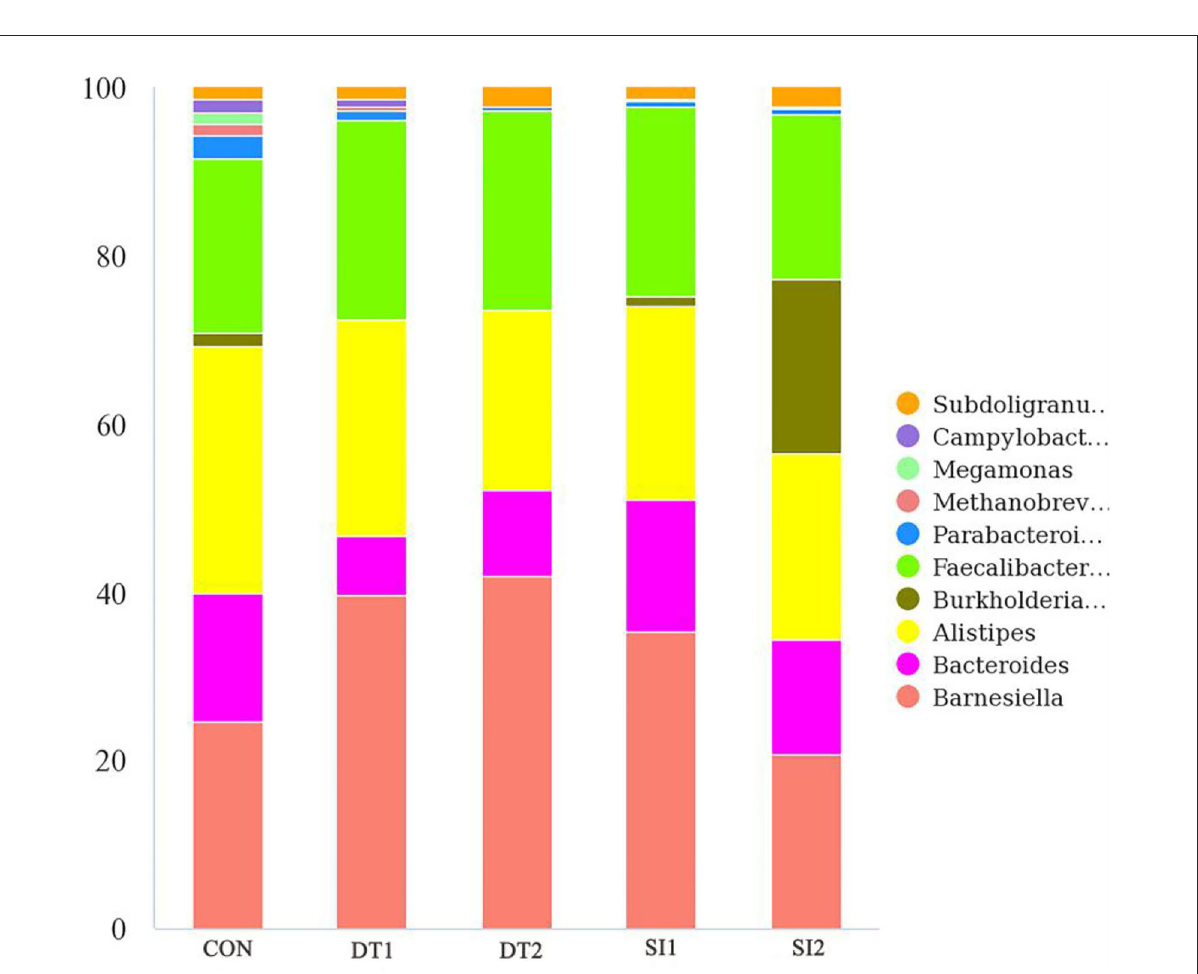
FIGURE6 The top 10 most abundant taxa of cecal microbiota at the genus level.